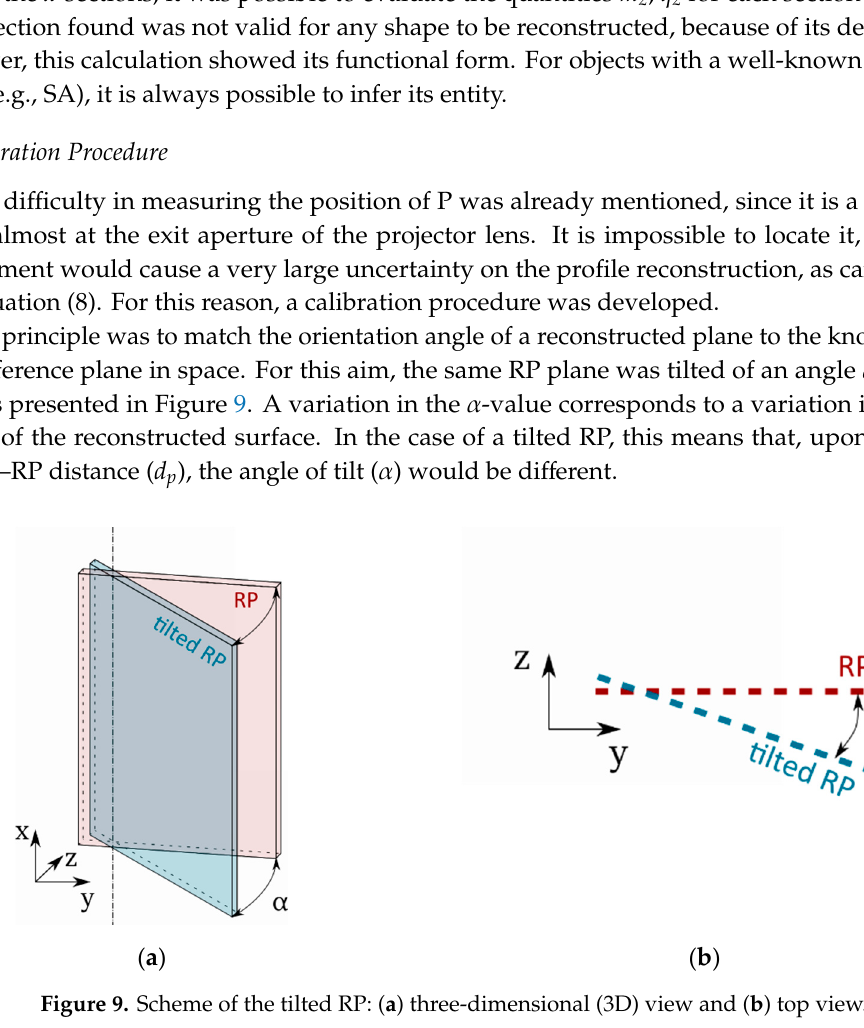
Figure 10. ( a ) Variation of the tilt angle in the reconstructed tilted RP for different virtual positions of the projector. The dashed line indicates the real value of the tilted angle. ( b ) Detail of the graph shown in ( a ) in proximity of the real value of 𝑑 (cid:3017) . The straight line indicates the expected value of tilt angle, while the dashed lines indicate its uncertainty interval.